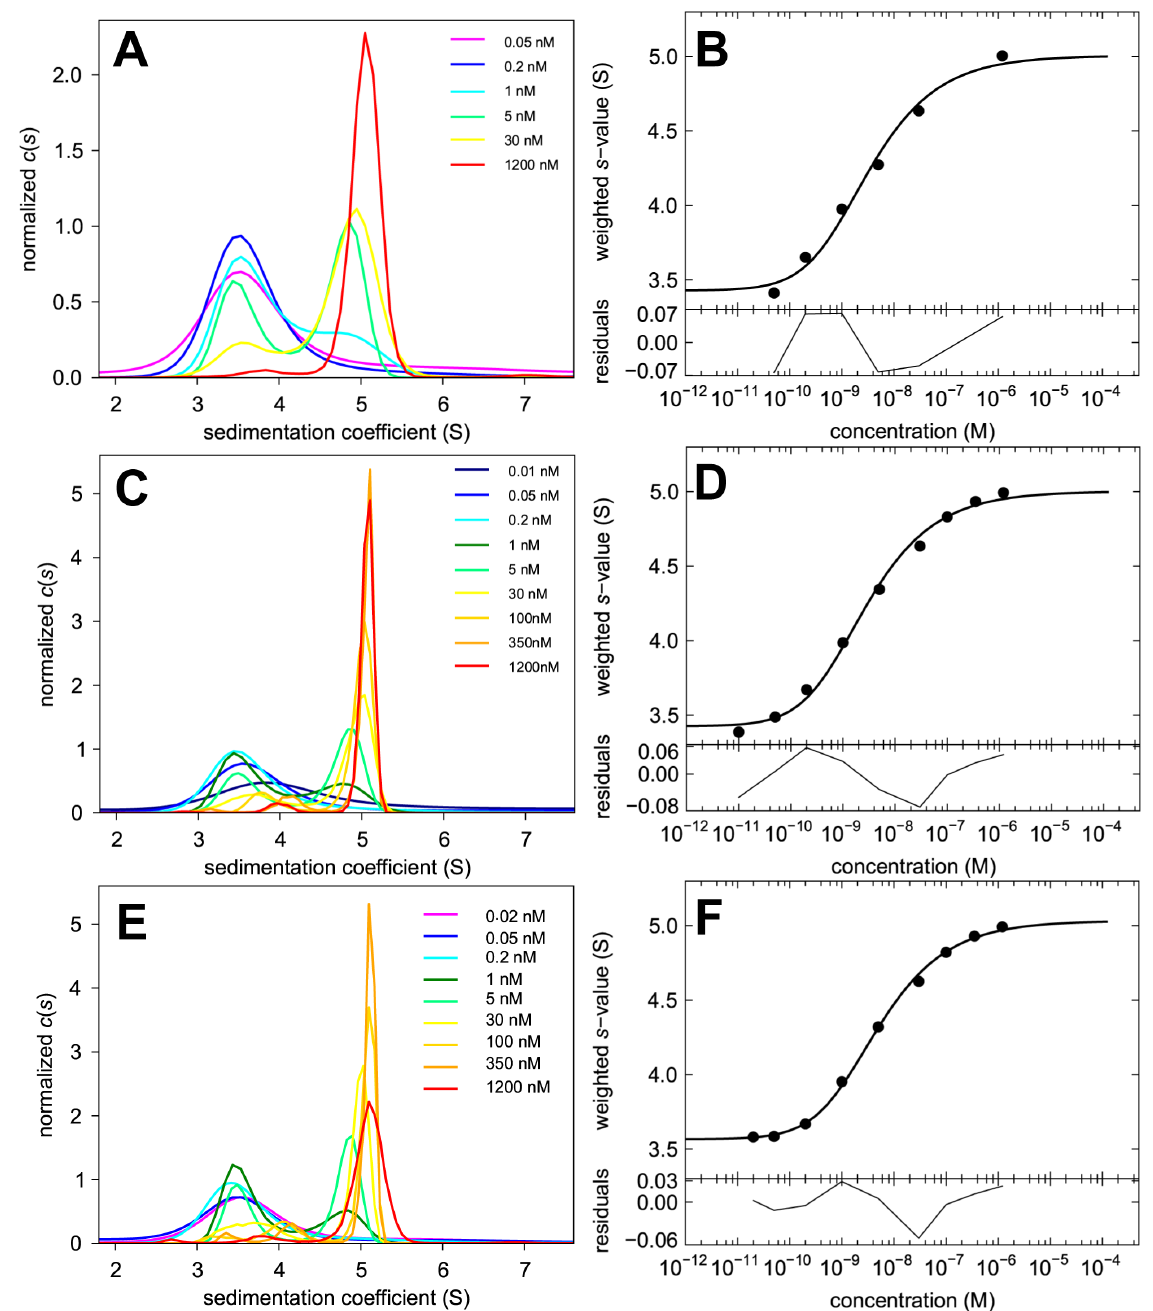
Figure 4. Dilution series for FAM-GluA2 ATD at different labeling ratios. Shown are the sedimentation coefficient distribution distributions c ( s ) (Panels A, C, and E) and the resulting s w isotherms (Panels B, D, and F) from integration of c ( s ) for FAM-GluA2 ATD at labeling ratios of 0.68 (first row), 1.05 (second row) and 2.26 (third row). Analogous to Figure 3, in the c ( s ) plots the distributions were normalized with respect to the loading concentrations indicated, and in the isotherm plots, solid circles are the s w data from the dilution series, and the solid line is the best-fit isotherm with a monomer-dimer model. This resulted in best-fit values at the labeling ratio of 0.68 (Panel B) of K D =3.1 nM (95% CI 0.16 – 30.5), s 1 =3.43 S (95% CI 2.53 – 3.82), and s 2 =5.01 S (95% CI 4.60 – 5.51); for the labeling ratio of 1.05 (Panel D) the best-fit values were K D =2.6 nM (95% CI 1.1 – 5.9), s 1 =3.42 S (95% CI 3.27 – 3.56), and s 2 =5.00 S (95% CI 4.88 – 5.14); and for the labeling ratio of 2.26 (Panel F) the best-fit values were K D =4.7 nM (95% CI 3.0 – 7.3), s 1 =3.57 S (95% CI 3.49 – 3.63), and s 2 =5.03 S (95% CI 4.96 – 5.11). doi:10.1371/journal.pone.0083439.g004 rmsd = 0.022 S, was achieved considering only the high-affinity Dylight488-GluA2, EGFP-GluA2, and FAM-GluA2 ATDs, and ‘native’ interactions (data not shown). we carried out FRET experiments in a benchtop spectrofluo- rometer, using AF568-GluA2 ATD as an acceptor and either To obtain independent evidence for FAM-GluA2 ATD species FAM, Dylight488 or EGFP labeled GluA2 ATD as donor. In heterogeneity, and to directly estimate dimer lifetimes for the